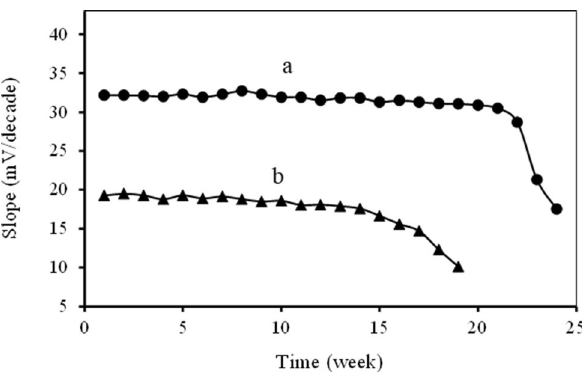
Figure 6. The lifetime of the ( a ) copper (II) and ( b ) chromium (III) selective CPEs.